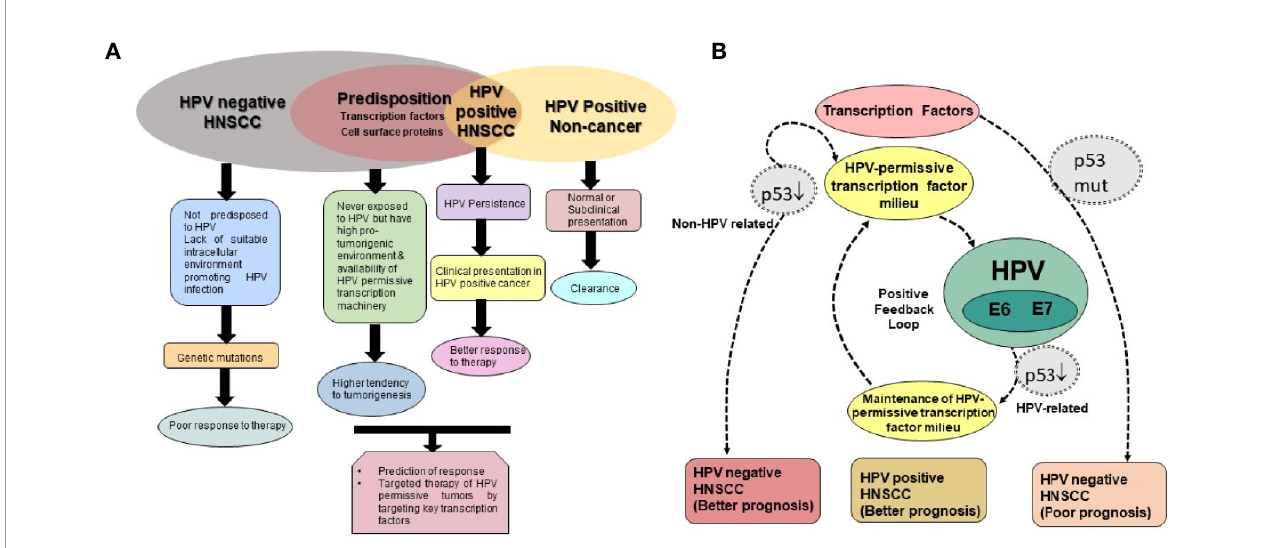
FIGURE 6 | Transcription factor-based classi fi cation of HPV positive and HPV negative HNSCC. (A) Schematic representation of molecular sub-types of HNSCC. HPV negative HNSCC collectively represent tumors with availability of HPV-permissive transcription factors that are never exposed to HPV infection in the lifetime and HPV negative tumors, which are driven by genetic mutations in p53 or other such genes. The later represent tumors with poorer prognosis. Further, not all individuals that encounter HPV in H&N region develop cancer. HPV positivity is reported in oral rinse of normal individual. HPV-permissive transcription factor cocktail if present is expected to direct treatment outcome similar to the tumor-tissue with HPV-driven transcription pro fi le. In the absence of HPV infection, such cases go unnoticed and clubbed with HPV negative HNSCC and could be effectively treated with less aggressive treatment regimen and likely to have a better treatment outcome. (B) Expression of viral oncogenes under the in fl uence of HPV-permissive transcription factor milieu lead to functional inactivation of p53 and feeds to a positive feedback look that maintains the HPV-permissive transcription factor milieu. On the other hand, HPV negative tumors, particularly with mutations in p53, in consort with other procarcinogenic transcription factors like STAT3 drive tumors that show poorer response to anti-cancer